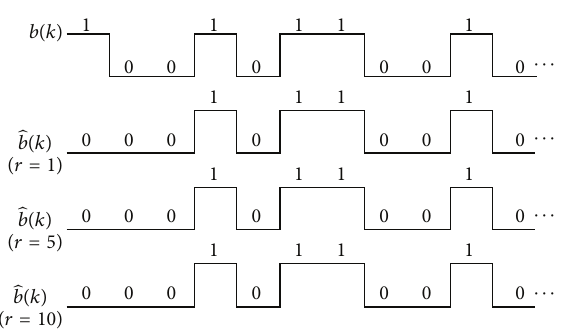
Figure 9: The recovered digital sequences for 𝑟 = 1 , 𝑟 = 5 , and 𝑟 = 10 , respectively, by the proposed demodulation method.